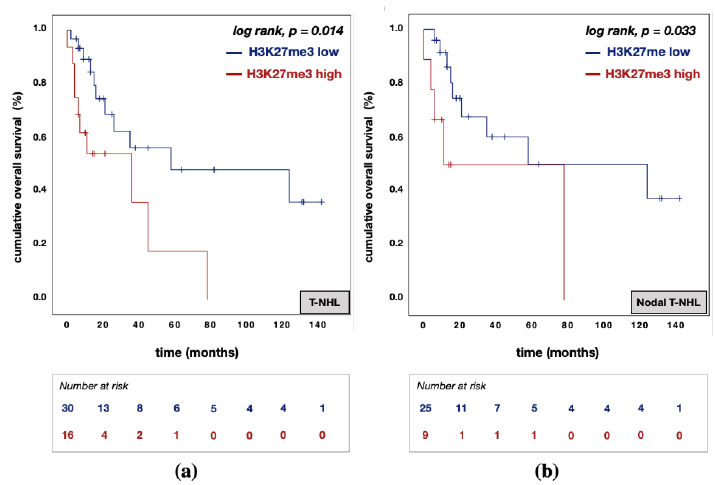
Figure 8. Kaplan – Meier (KM) curves for overall survival (OS) according to H3K27me3 protein expression. ( a ) KM curve for OS according to H3K27me3 protein expression in T-NHL. ( b ) KM curve for OS according to H3K27me3 protein expression in nodal T-NHL. Abbreviations: T-NHL — T-cell